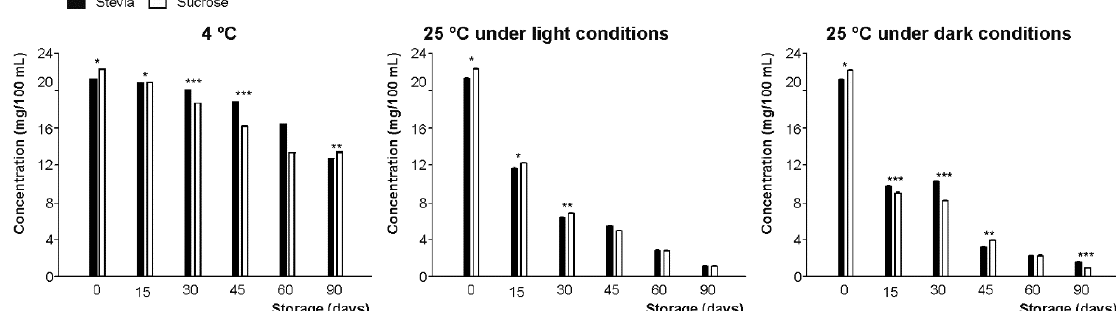
Figure 6. Content of total anthocyanins (µg/100 mL) of juices developed using stevia and sucrose as sweeteners, measured during storage for 90 days under three different conditions (4 °C and 25 °C under light conditions and 25 °C under dark conditions). Bars with asterisk(s) are significantly different according to the paired t -test developed at p < 0.05 (*), p < 0.01 (**), and p < 0.001 (***).